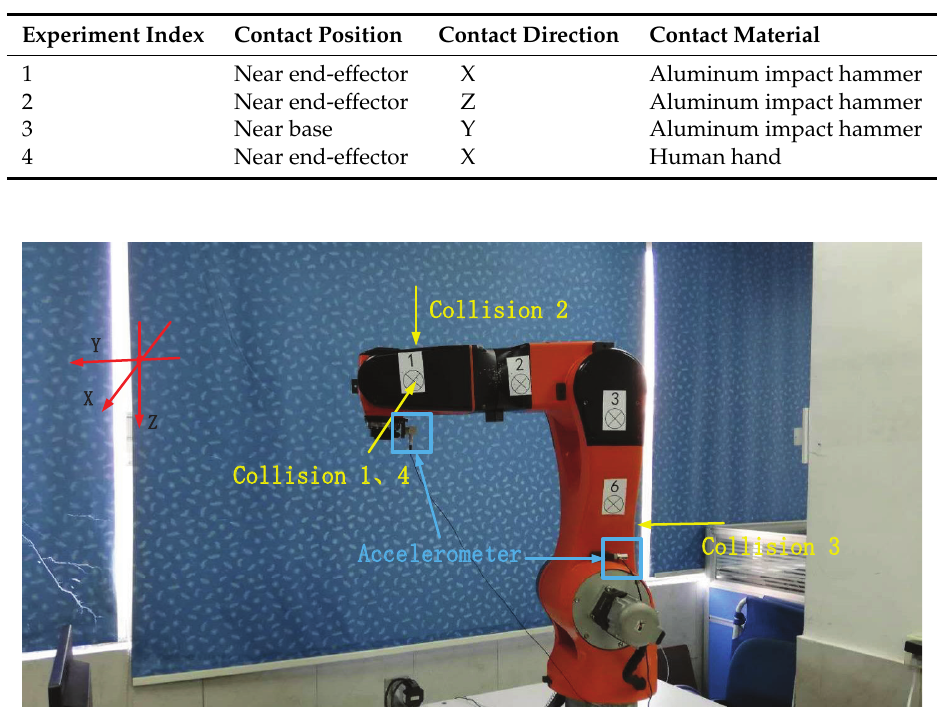
Figure 1. Experiment